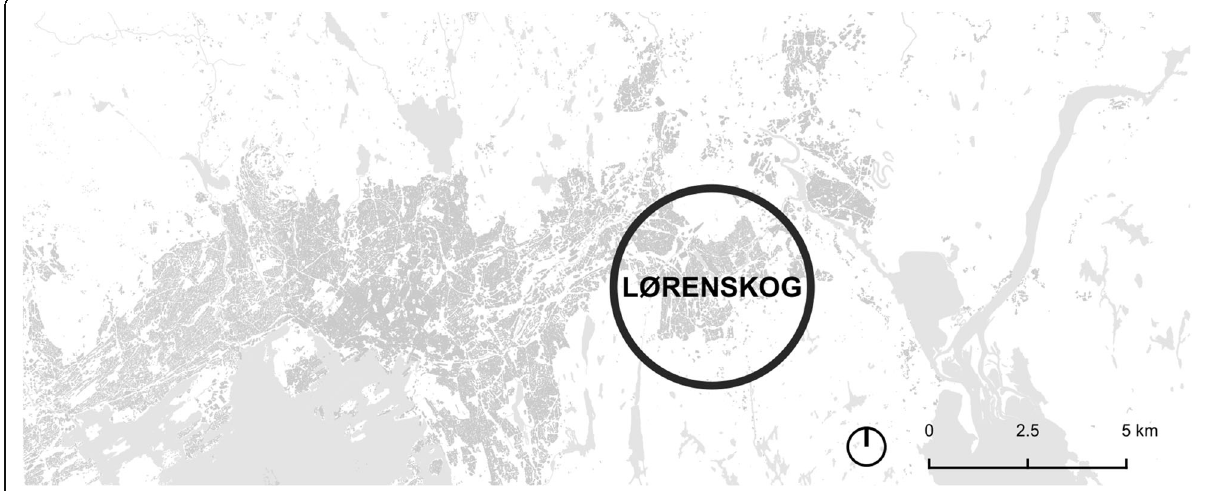
Fig. 2 The Oslo region, with